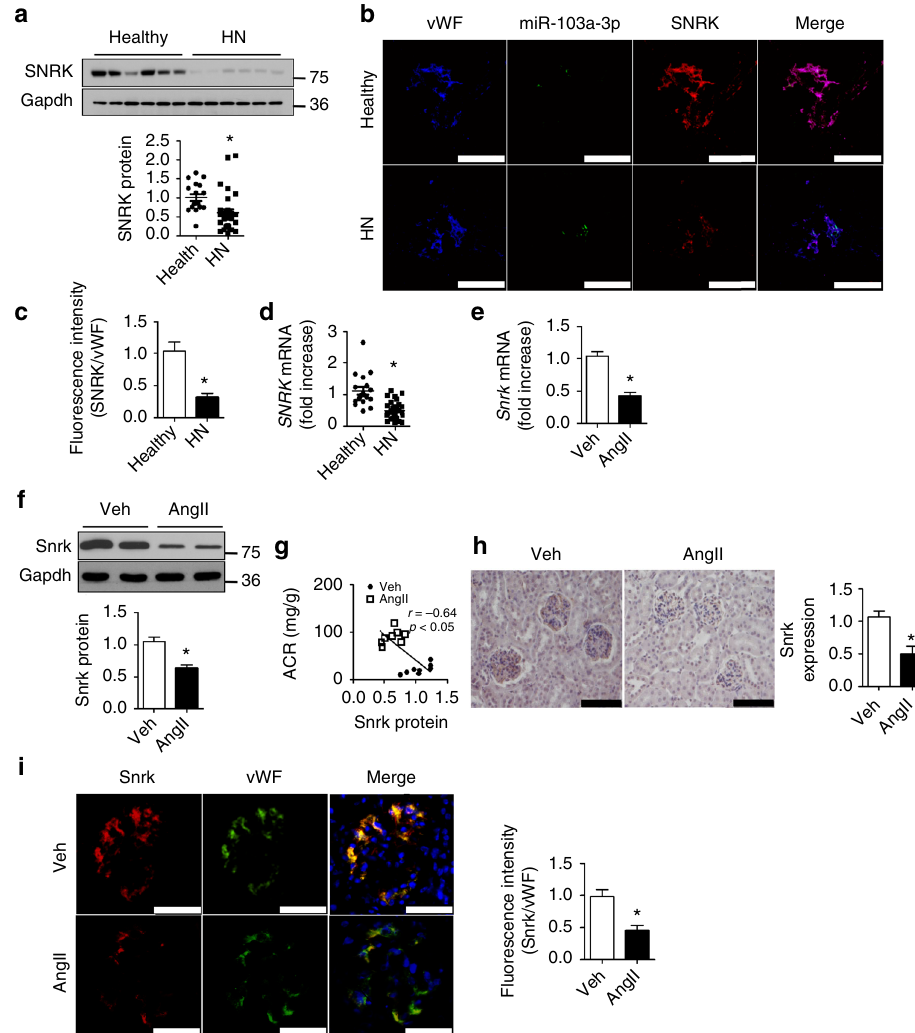
Fig. 5 SNRK protein is downregulated in renal endothelium of hypertensive nephropathy patients and AngII-treated mice. a SNRK protein levels in kidney tissues of healthy individuals and hypertensive nephropathy (HN) patients. * p < 0.05 relative to healthy controls. b Immuno fl uorescent co-staining of miR- 103a-3p (green), SNRK (red), and Von Willebrand factor (vWF; blue) in kidney tissues of healthy controls and HN patients (scale bar = 50 µ m). c Quantitative analysis of the colocalization of SNRK and vWF immuno fl uorescence signals in kidney tissues. n = 6; * p < 0.05 relative to healthy controls. d SNRK mRNA levels in kidney tissues were measured by qRT-PCR. n = 6; * p < 0.05 relative to healthy controls. e - i Mice were infused with a vehicle control (Veh) or AngII (1 mg kg − 1 d − 1 ) for 4 weeks. e Snrk mRNA levels in kidney tissues were measured using qRT-PCR. f Snrk protein levels in kidney tissues were measured using Western blot analysis. g Correlation between renal Snrk protein levels and the albumin/creatinine ratio in mice with or without AngII infusion. h Immunohistochemical staining of Snrk in mouse kidney sections (scale bar = 100 µ m). i Immuno fl uorescence staining of Snrk (red) and vWF (green) in kidney sections from vehicle- or AngII-treated mice (scale bar = 50 µ m). For murine experiments, n = 8; * p < 0.05 relative to vehicle control. Statistical analysis was carried out with a Student ’ s two-tailed t -test. The corresponding source data are available in the Source Data fi